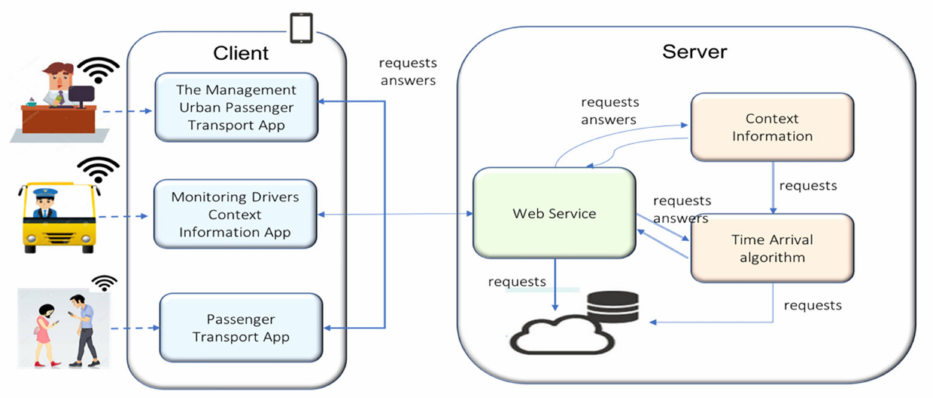
Figure 11. Architecture of the smart information